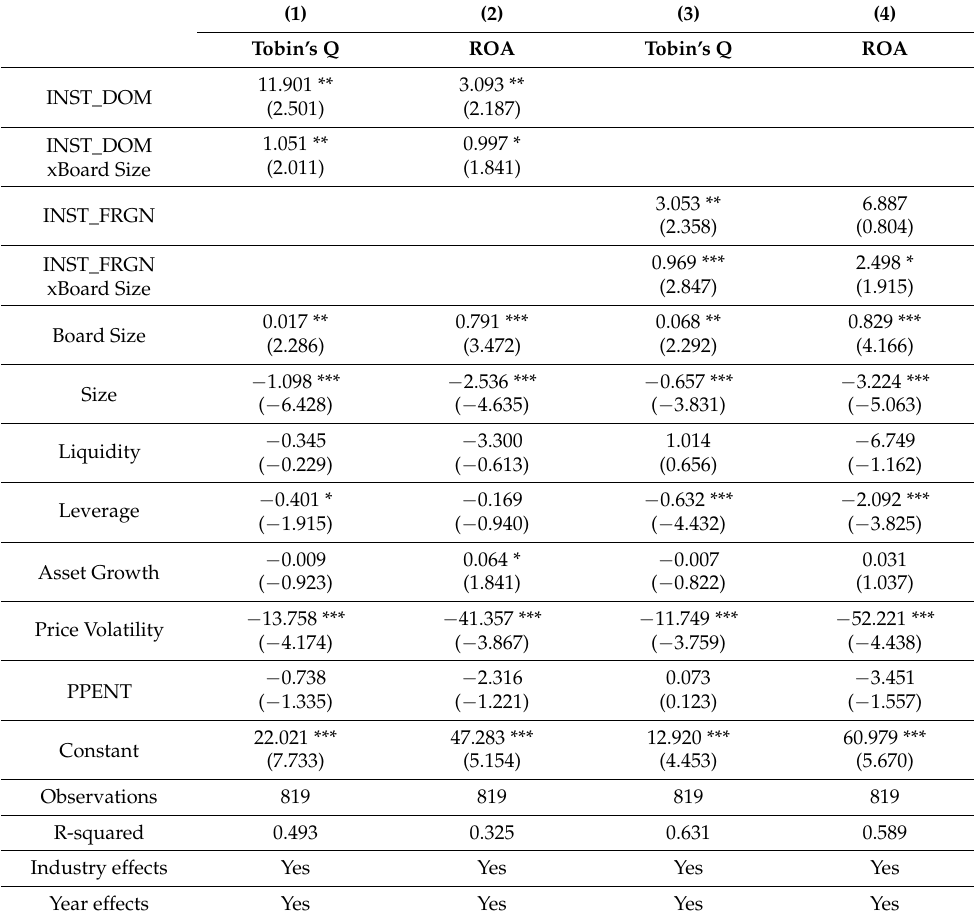
Table 6. Mediating impact of Board size on the relationship between institutional ownership and firm